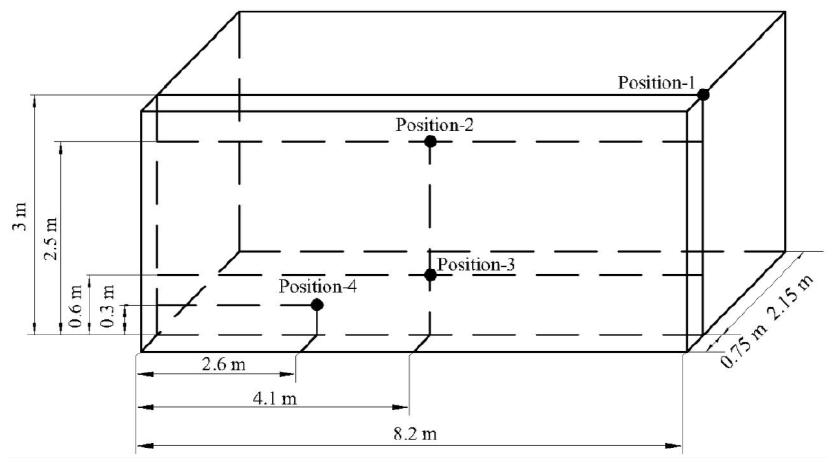
Figure 3. Distribution of temperature and humidity sensors.